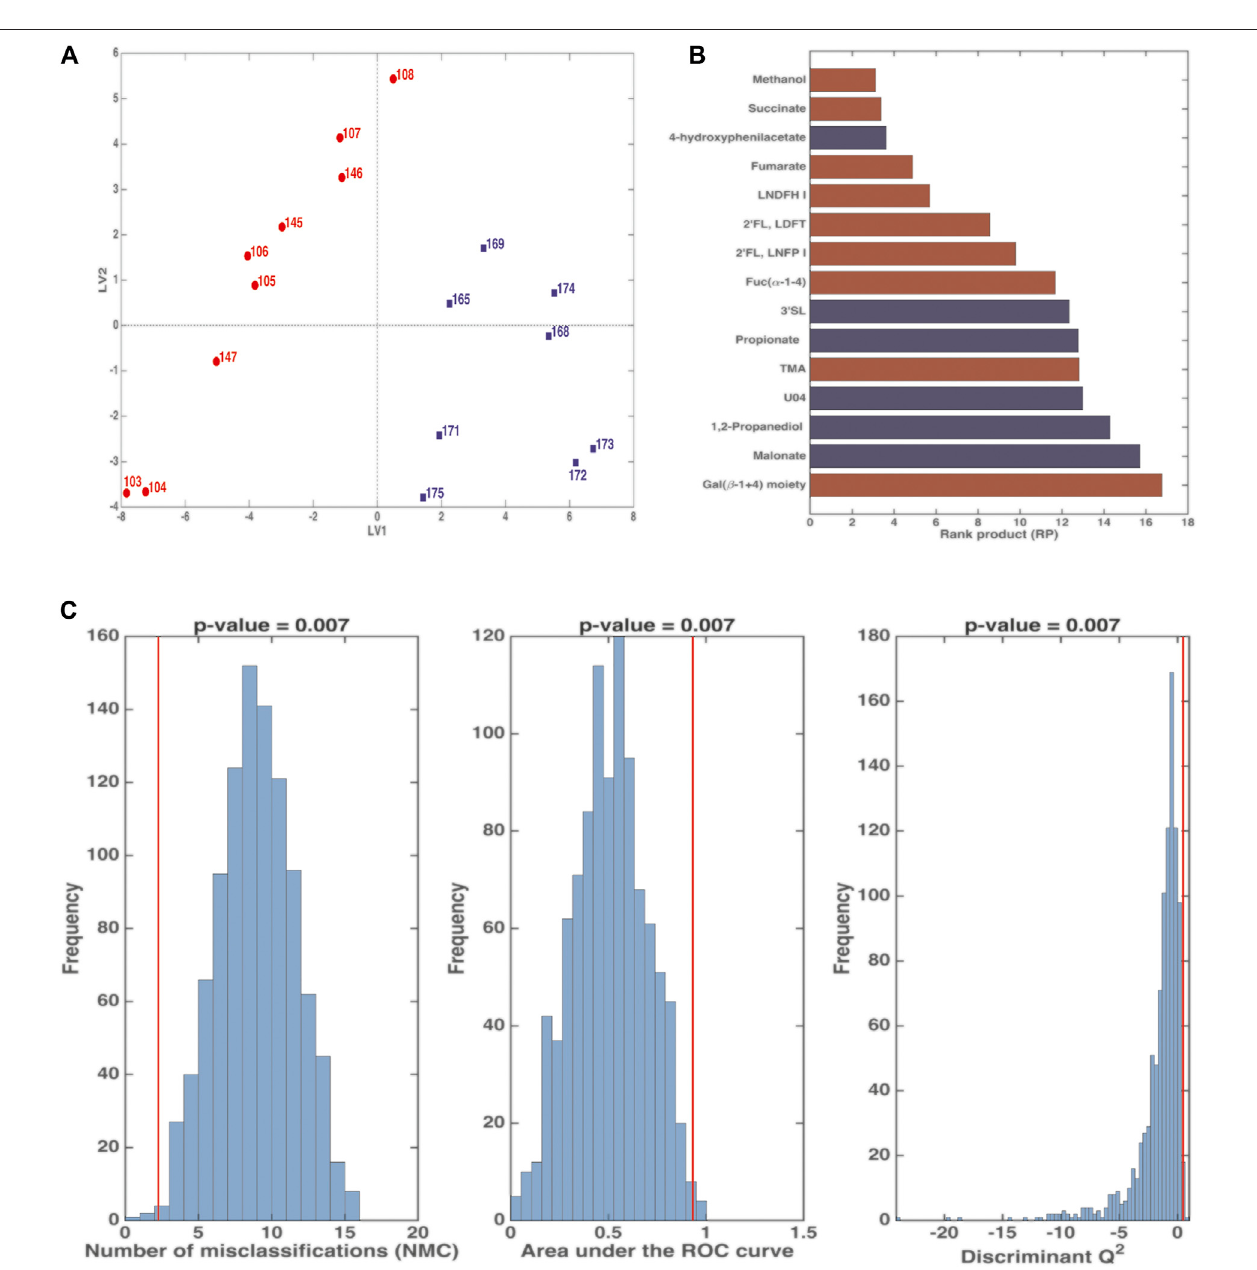
FIGURE 4 | PLS-DA analysis in Double Cross Validation (DCV) of stool samples on BM (red) and FBM (blue) periods. Panel (A) reports latent variables (LV) scores plot. Panel (B) reports the variables that signi fi cantly contributes to the PLS-DA model by means of the rank product (RP). The criterion RP < average RP was used to identify the potential markers, that are the ones displayed as bar plot in the panel. Red variables were higher in the BM period; blue variables were higher in the FBM period. Panel (C) reports the validation of the PLS-DA model. The fi gures of merit namely Number of Misclassi fi cations (NMC), Area Under the Receiver Operating Characteristic curve (AUROC) and Discriminant Q 2 (DQ 2 ), calculated on the outer cross-validation loop (red vertical bars) were compared to their respective distribution under the null hypothesis (estimated by means of permutation test), indicating that the discrimination observed is statistically signi fi